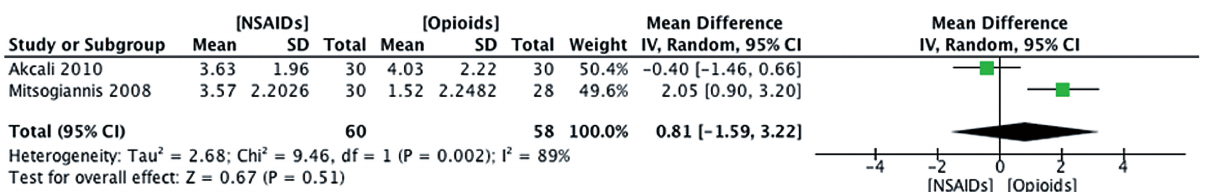
figure 2 - comparison between nsAIDs and opioids, visual analogue score at 10 minutes.